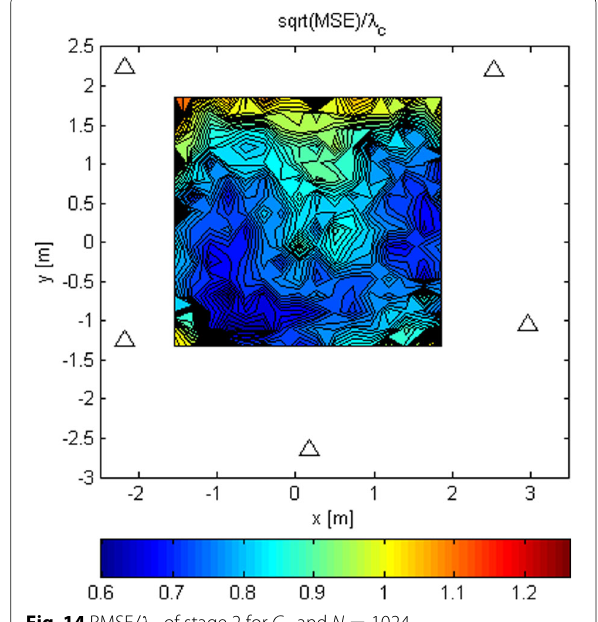
The contour plots in the rest of the section were gen- erated over a Tx grid of 16 × 16 points that covers most of the area inside the array to show the error distribution across space. The grid has uniformly spaced points in the plane z = 0.